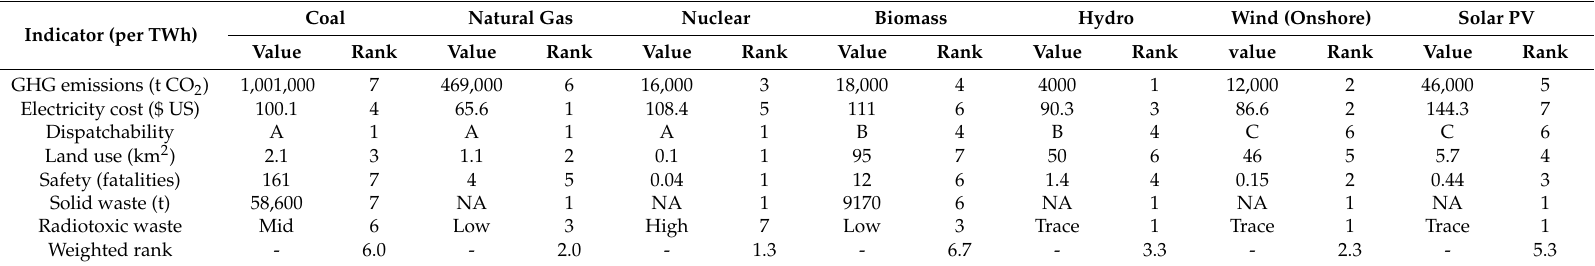
Table 9. Data and ranks of power generation sources based on sustenance, economy, and environmental effects. GHG: greenhouse gas, PV: photovoltaic. Indicator (per